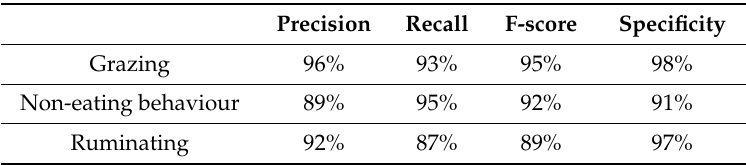
Table 6. Performance of the classification using collar data and 39 features of specific eating behavioural activities based on random forest.